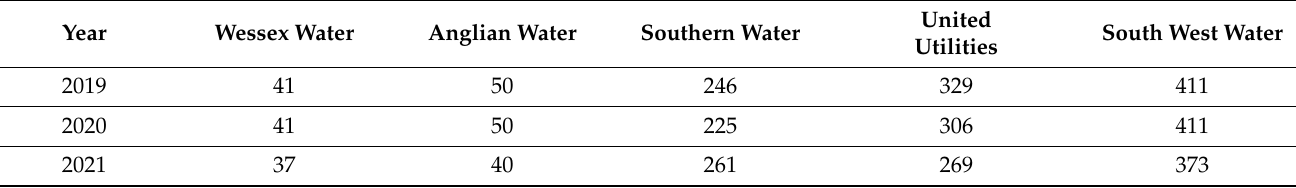
Table 1. Number of SOs reported across the five WaSCs by